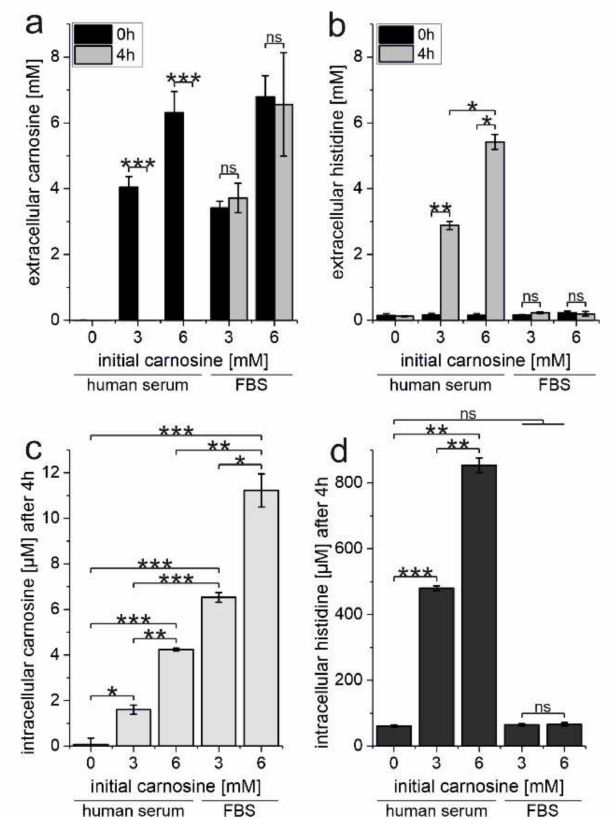
Figure 4. Uptake of carnosine into erythrocytes protects it from degradation by serum carnosinase as revealed by intra- and extracellular concentrations of carnosine in erythrocytes cultivated in the presence of human serum. Erythrocytes of a healthy volunteer (male, age 29) were incubated in the presence of 40% human serum or 40% FBS and 0, 3, or 6 mM carnosine. After 4 h of incubation and before the start of the experiment (0 h) the concentration of carnosine and L -histidine in the medium (black bars, a , b ) and the erythrocytes ( c , d ) were determined. (Note: no bars are seen indicating extracellular concentrations of carnosine after 4-h incubation in humans (panel a) because the concentration is already below detection limit after this incubation time due to carnosinase activity). All measurements were performed in triplicate; statistical significance was performed by one-way ANOVA with Games–Howell post hoc test: ns: not significant; * p < 0.05; ** p < 0.005; *** p <